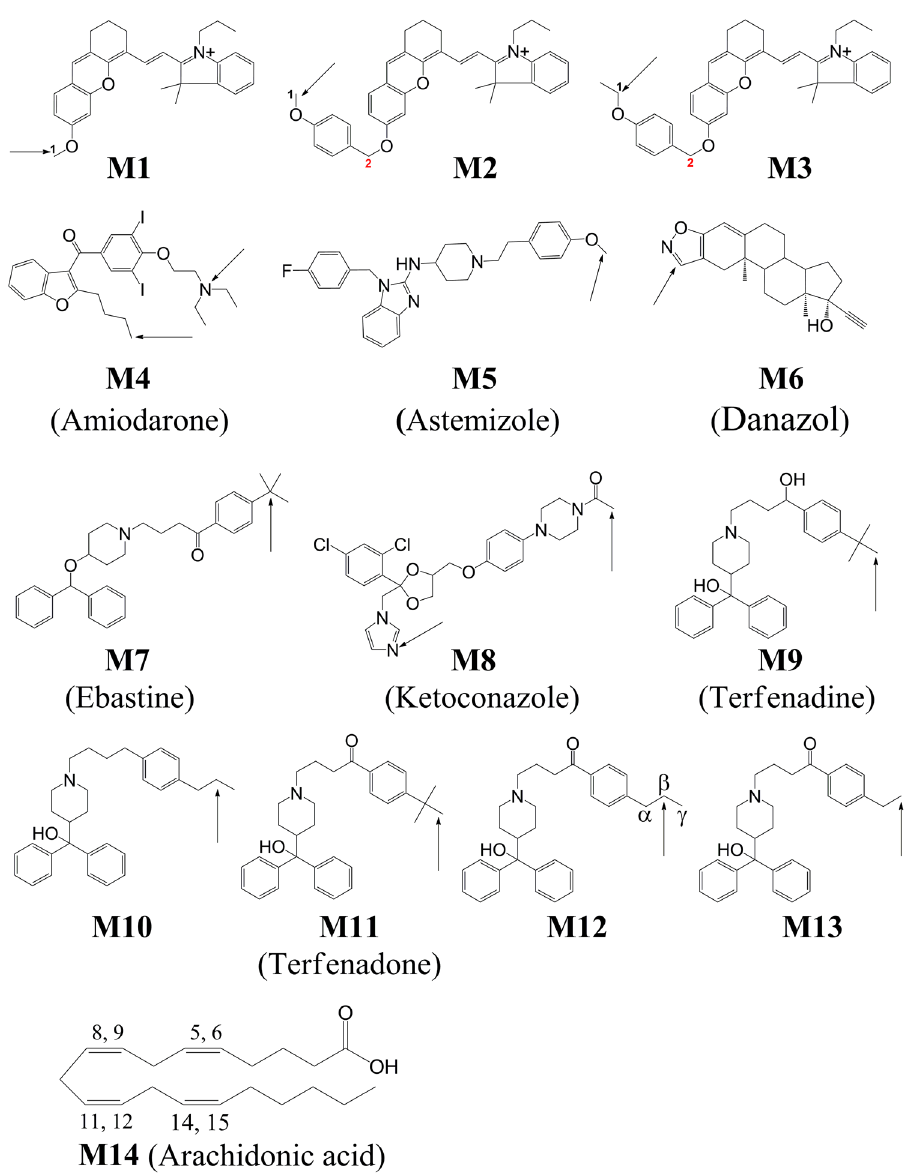
Figure 1. Molecular structures of M1 – M14 used in this work. The C 1 in M1 – M3 indicated the actual metabolic site catalyzed by CYP2J2 whereas the C 2 in M2 and M3 was the metabolic site predicted by current molecular docking studies. The potential metabolic sites of M4 – M14 was indicated by an arrow ( M4 – M13 ) or labels ( M14 ). The metabolic site of M1 – M3 was adopted from reference 25 ; The metabolic site of M4 was adopted from reference 14 ; The metabolic site of M5 was adopted from reference 10 ; The metabolic site of M6 was adopted from reference 13 ; The metabolic site of M7 was adopted from reference 11 ; The metabolic site of M8 was adopted from CYP3A4 in complex with two M8 (PDB ID: 2J0C, see reference 23 ) and reference 26 ; The metabolic site of M9– M13 was adopted from reference 12 ; and The metabolic site of M14 was adopted from reference 6